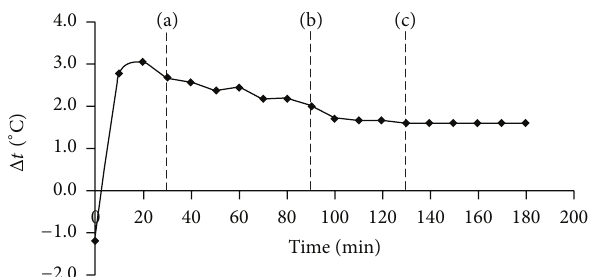
Figure 5: Dynamics of temperature difference between the incuba- tion medium and the oxygen sensor electrolyte (a) at temperature equilibrium of the thermostat; (b) at temperature equilibrium of the incubation medium; and (c) at temperature equilibrium of the sensor electrolyte. Electrolyte of sensor clearly begins to warm up before stabilization of the thermostat’s temperature (a). Because rate of thermostat’s heating near the temperature of the thermostating is sharply slowed down, speed of the electrolyte’s warming-up exceeds the rate of warming up of the medium from 20 to 130min (c) from the moment of switching the thermostat. Thus, conditions for the diffusion of gases from the sensor to the incubation medium remain over 110min. Stabilization of the medium temperature (b) does not render appreciable influence on this